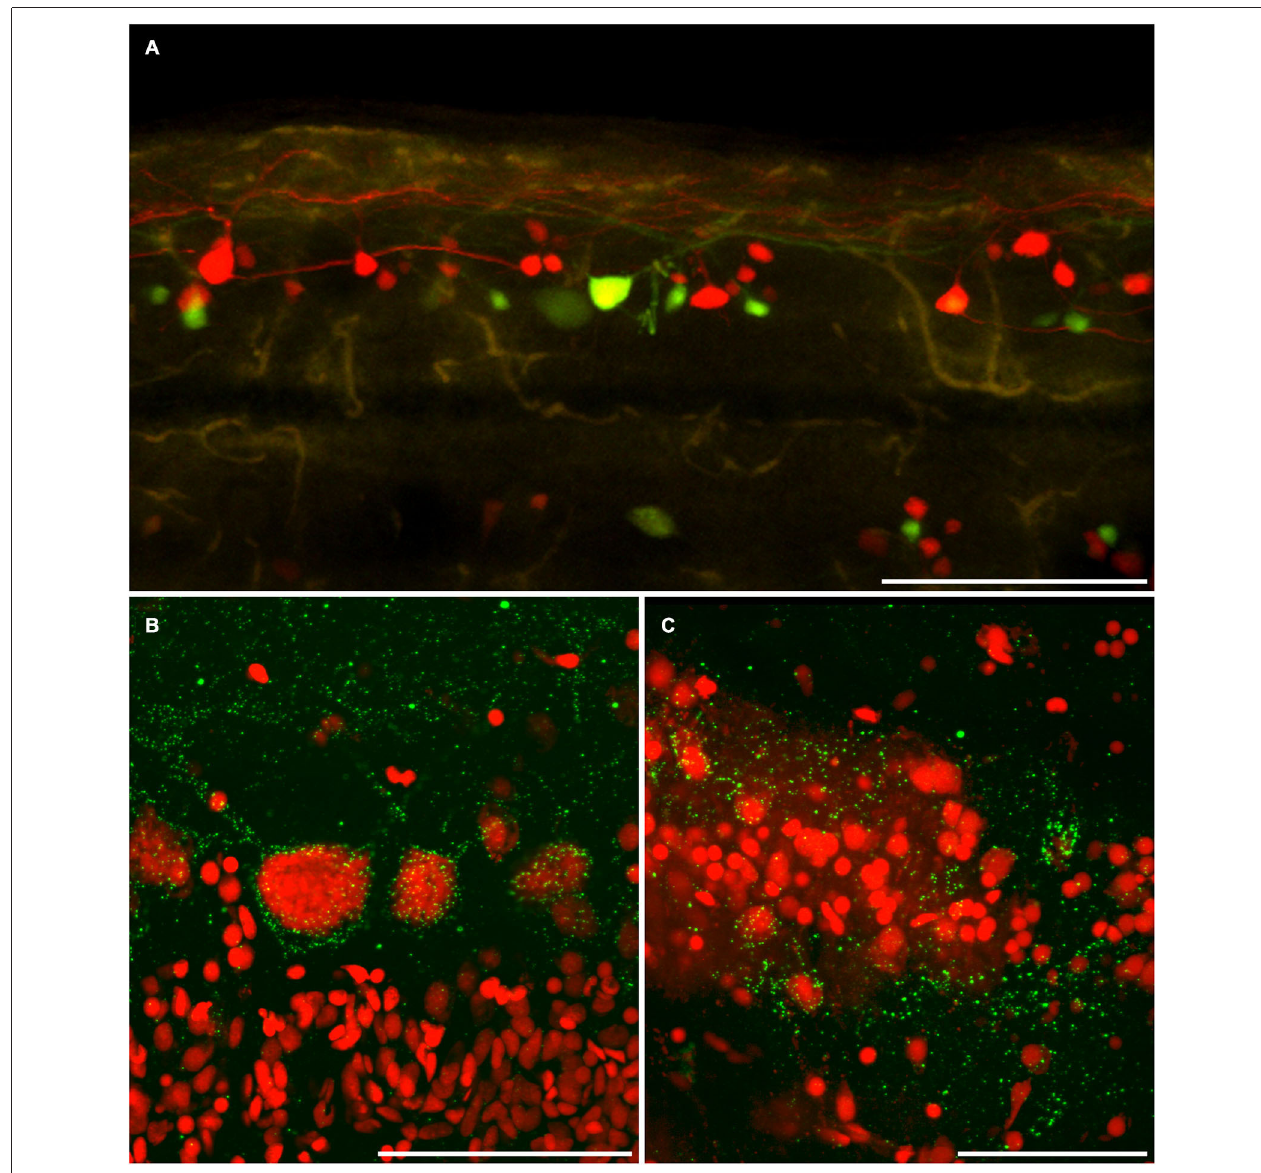
immunohistochemistry with anti-Cx35 antibody confirms the widespread presence of connexins (green puncta) in both male (B) and female (C) Mosquitofish. Calibration bars equals (A) 200 um, (B,C) 50